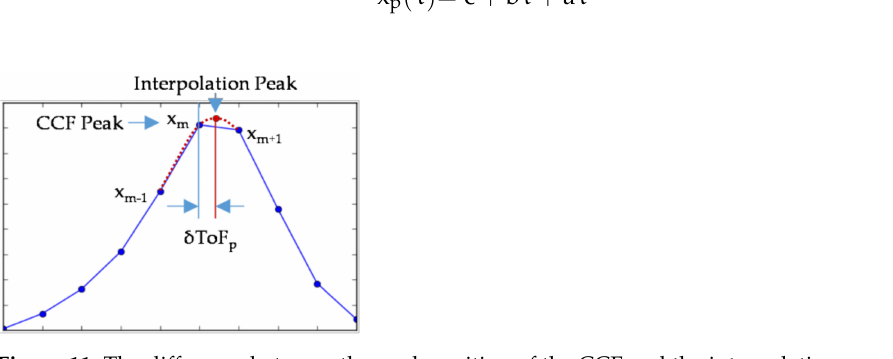
Figure 11. The difference between the peak position of the CCF and the